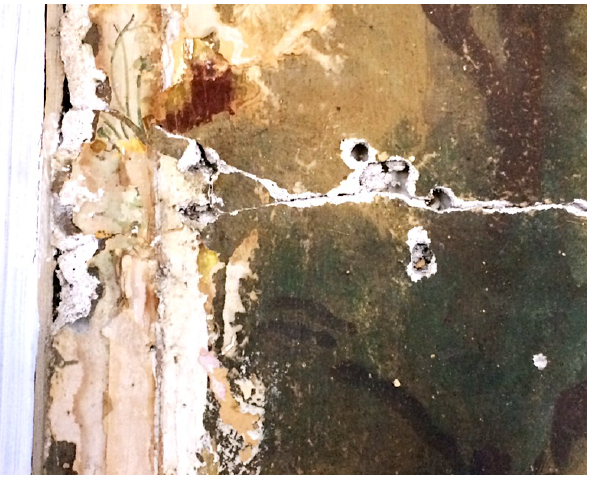
Figure 10: Post capture enhancement with iDStretch